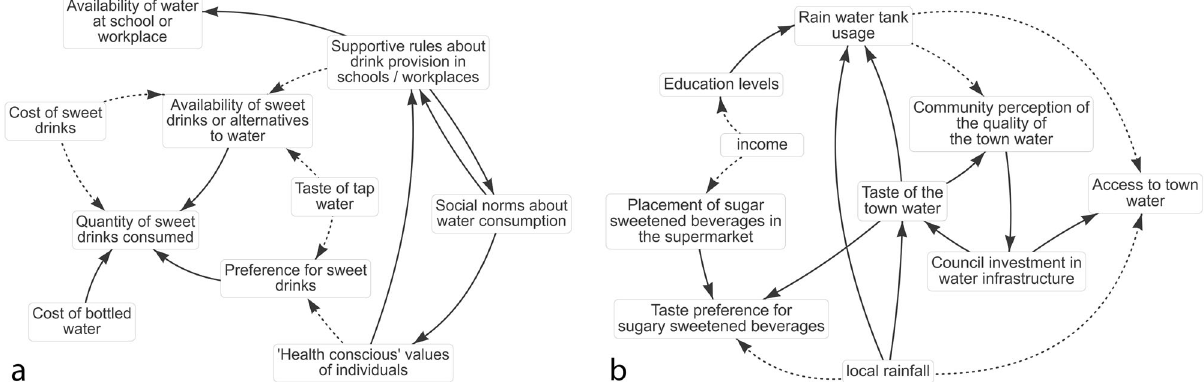
Fig. 1 Examples of two individual diagrams from STICKE. Diagrams are composed of factors identi fi ed by the user as important causes of the problem under consideration (text boxes) and causal connections between them (arrows). Positive causal relationships are denoted by a solid arrow pointing from the cause to the effect. Inverse causal relationships are denoted by a dashed arrow pointing from the cause to the